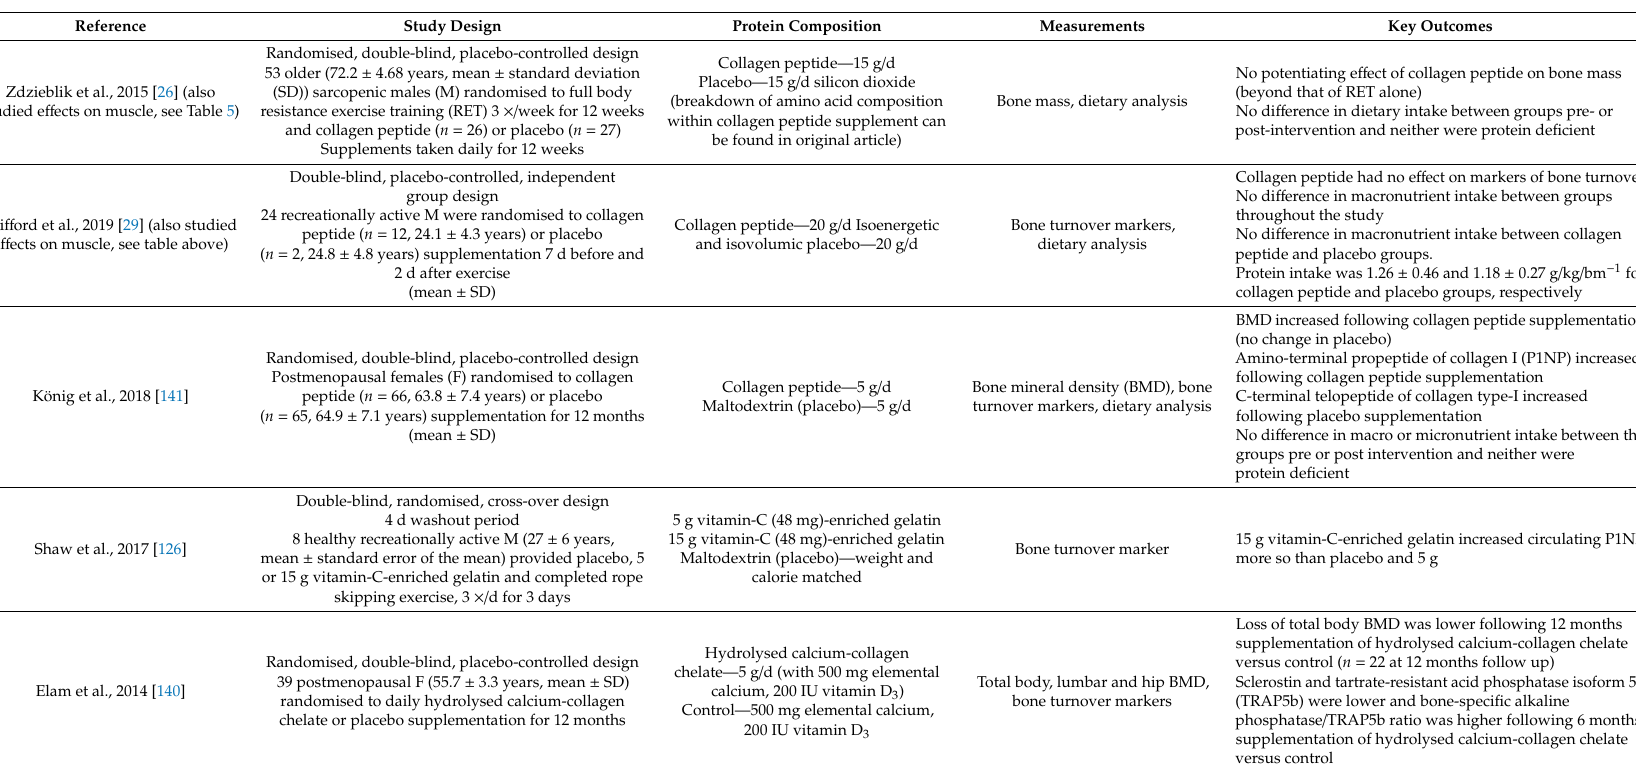
Table 6. Collagen-derived proteins: e ff ects on bone in relation to age, exercise, energy restriction and